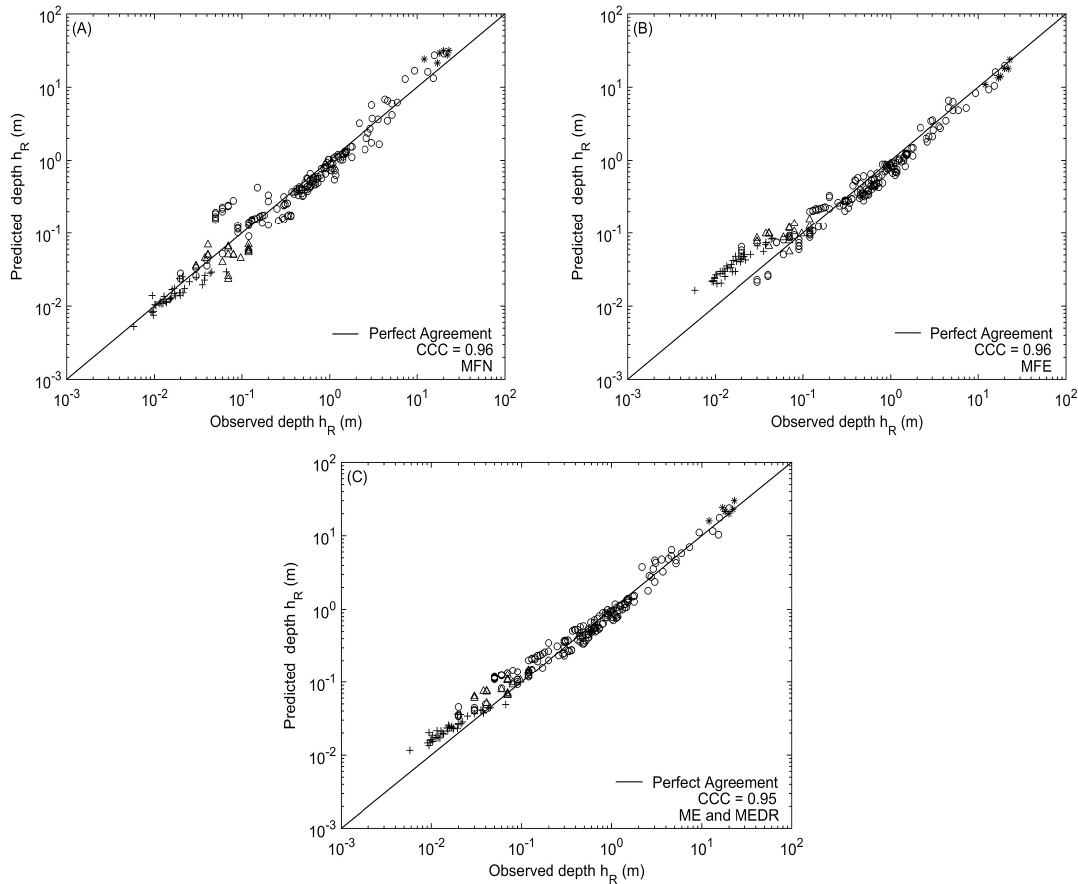
Figure 1. Comparison of predicted and observed widths B (cid:2902) for sand bed channels [26,44–46]. ( A ) MFN; ( B ) MFE; ( C ) ME and MEDR.